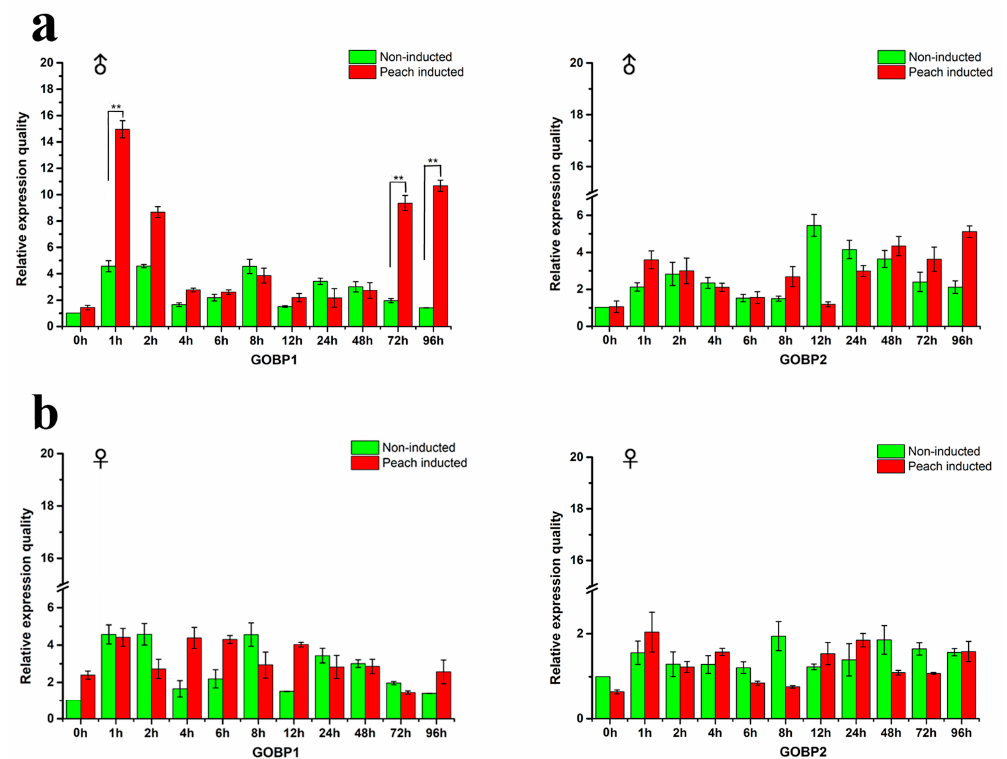
Figure 2. Expression profiles of GOBP genes in yellow peach moth antennae in different times. ( a ) and ( b ) showed the expression of GOBP genes in male and female moth antennae, respectively. The gene expression level between the inducted and non-inducted adults at different hours was statistically significant ( t -test ,** P < 0.01).